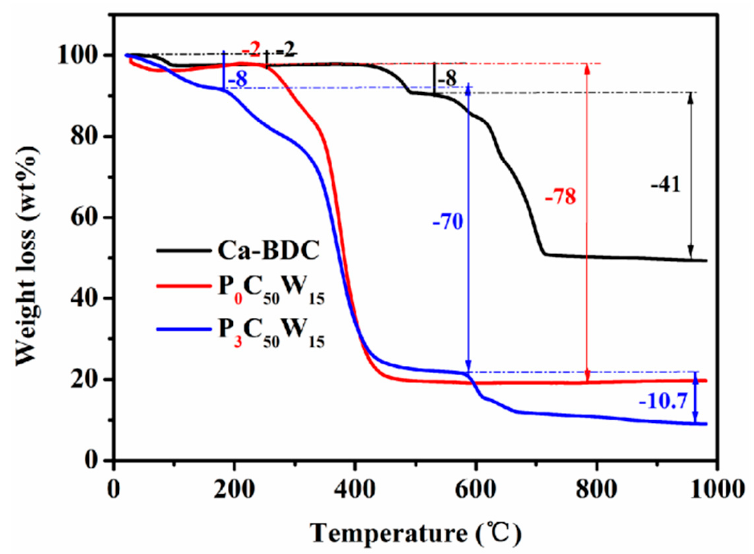
Figure 8. The TG curves of Ca-BDC, P 0 C 50 W 15 and P 3 C 50 W 15 templated from C / W HIPEs containing 0 and 3 g Ca-BDC, respectively.